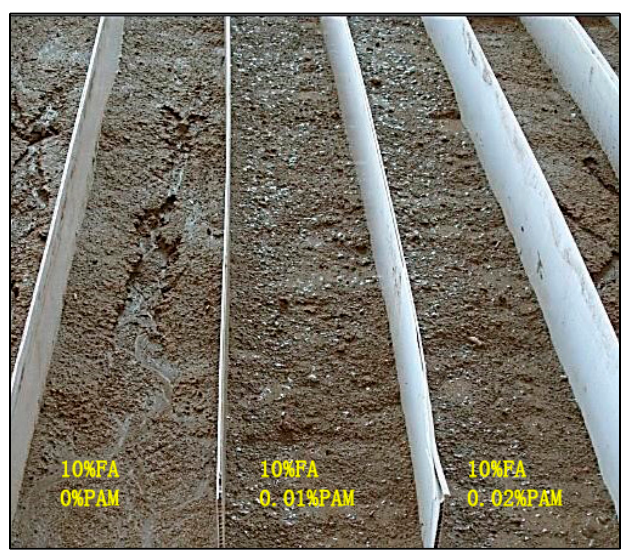
Figure 7. Surface morphology of soil treated with 10% coal fly ash (FA) and varying polyacrylamide (PAM) rates.